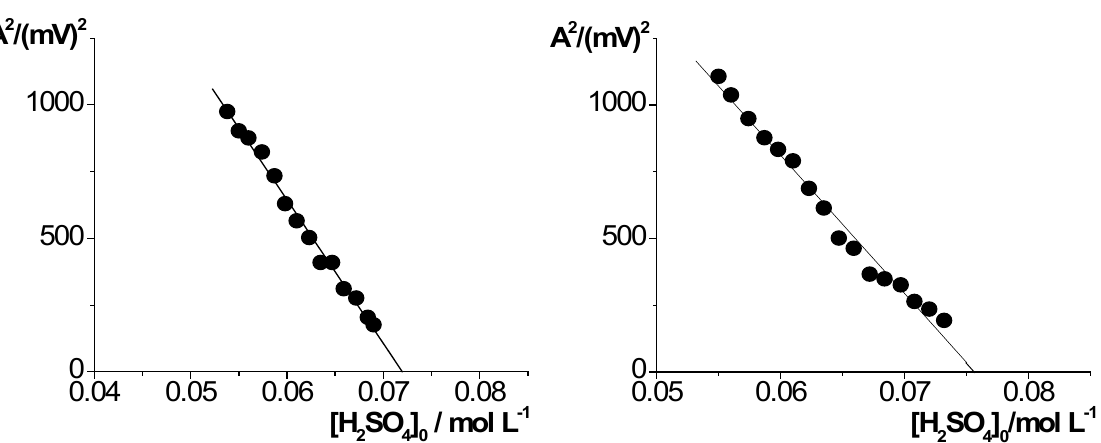
Figure 3. Plot of the square of the amplitude of regular oscillations as a function of the acidity obtained at temperature 55.0°C (a) and 58.0°C (b). The abscissa intercept corresponds to the bifurcation values of the inflow concentration of sulfuric acid, [H ((T = 55.0°C) and [H SO ] = 7.57×10 −2 mol L -1 (T = 2 4 0